Question: Write a descriptive caption for this figure.
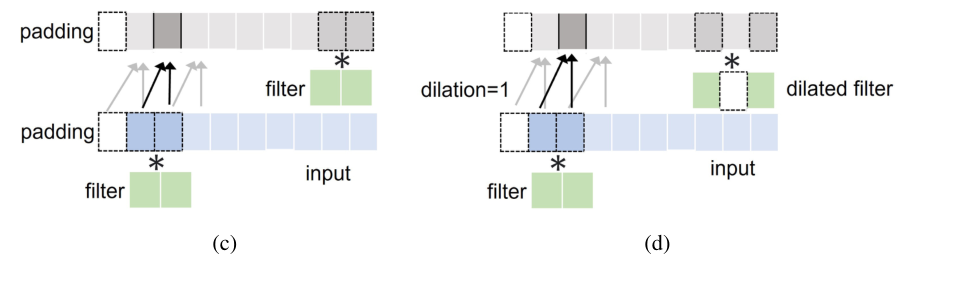
Answer: Illustration of different types of CNN convolutions for a 9-length time-series: (a) standard (vanilla) convolution process by a 3-length filter, (b) padded convolution, (c) casual convolution and (d) dilated- causal convolution by a 2-length filter.